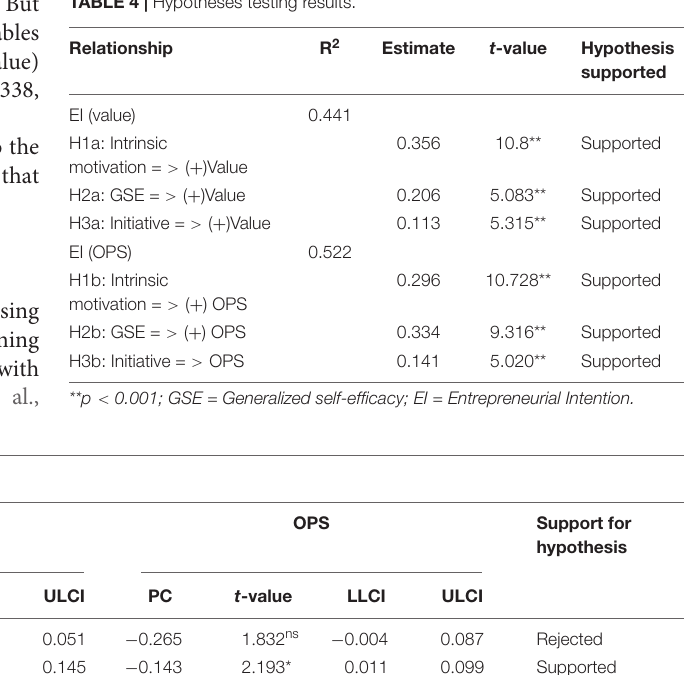
TABLE 4 | Hypotheses testing results.